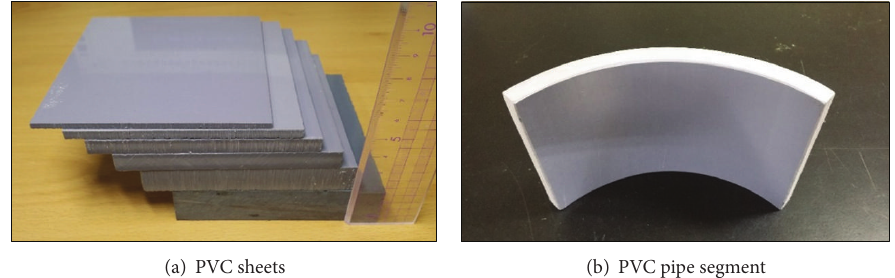
Figure 2: PVC specimens: (a) sheets and (b) pipe segment.